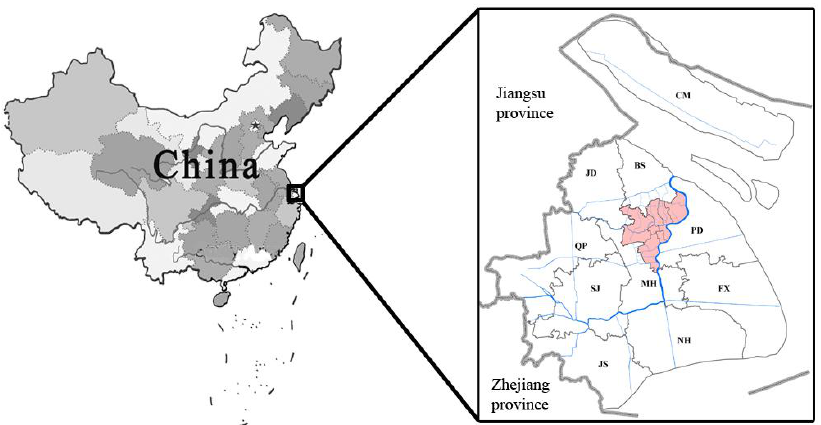
Figure 1. Location of the Shanghai